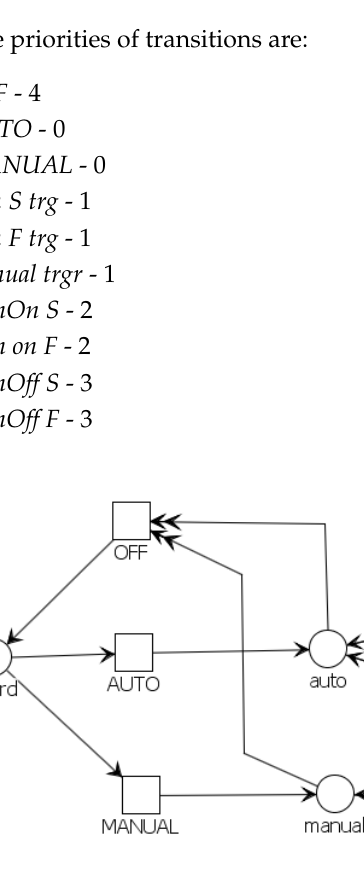
Figure 10. Petri net for control of laboratory car wiper